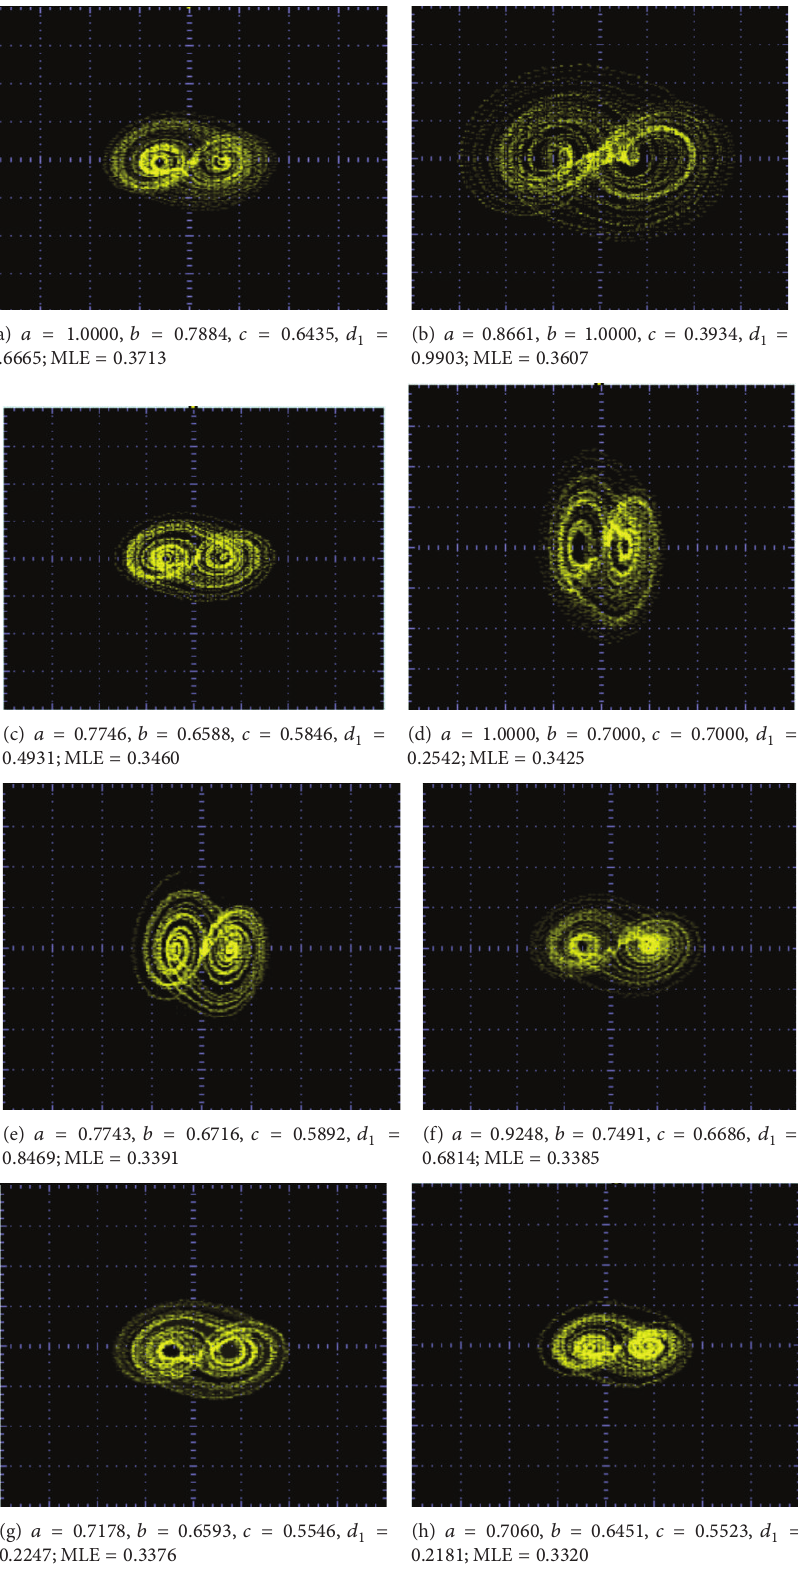
Figure 9: Optimized MLE for generating 2